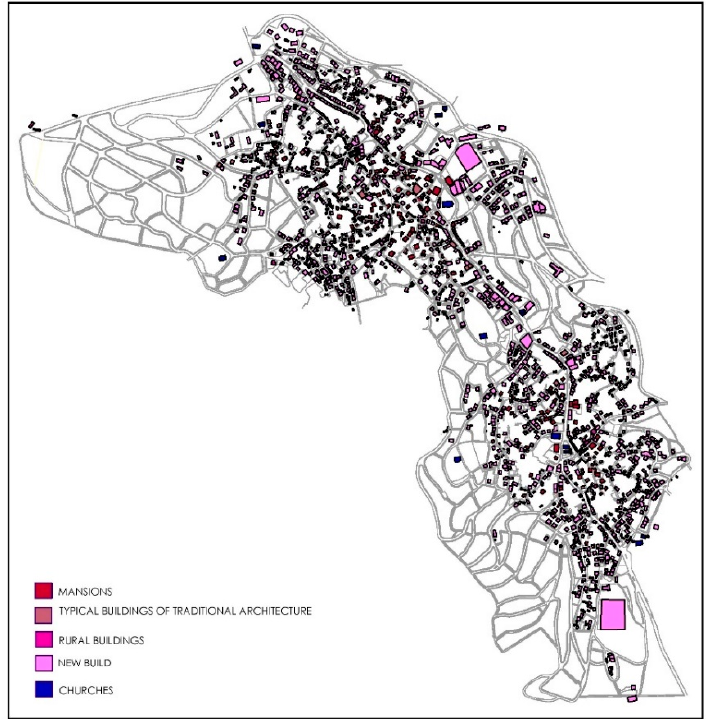
Figure 7. Type of buildings in the area.